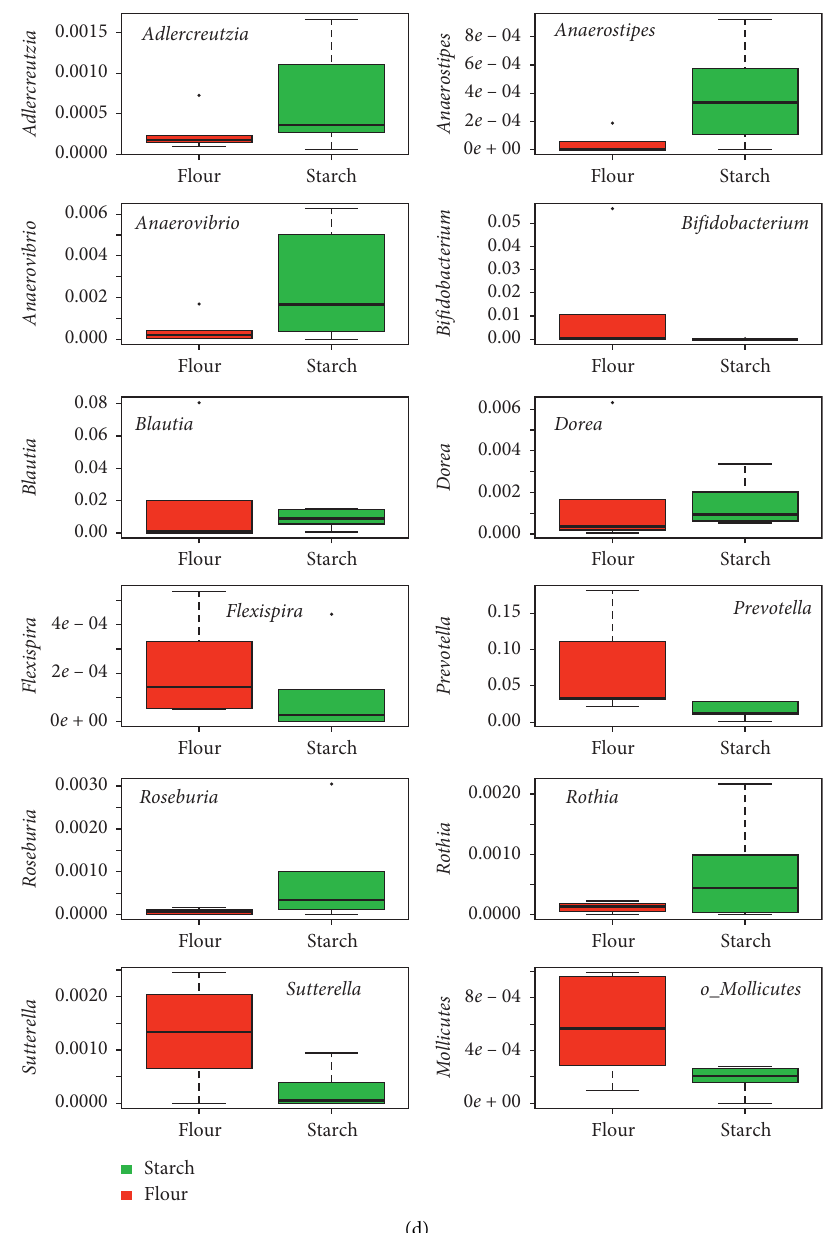
Figure 5: Box plots of those OTUs that were different (using LEfSe, Random Forest (top 10 OTUs) and Kruskal–Wallis correlation) between the microbiota from DM and non-DM rats at week 4 (a), AIN- and non-AIN-fed rats at week 4 (b), between the microbiota from DM and non- DM rats from only the taro flour- and taro starch-fed rats (c), and between the microbiota from the taro flour- or taro starch-fed rats